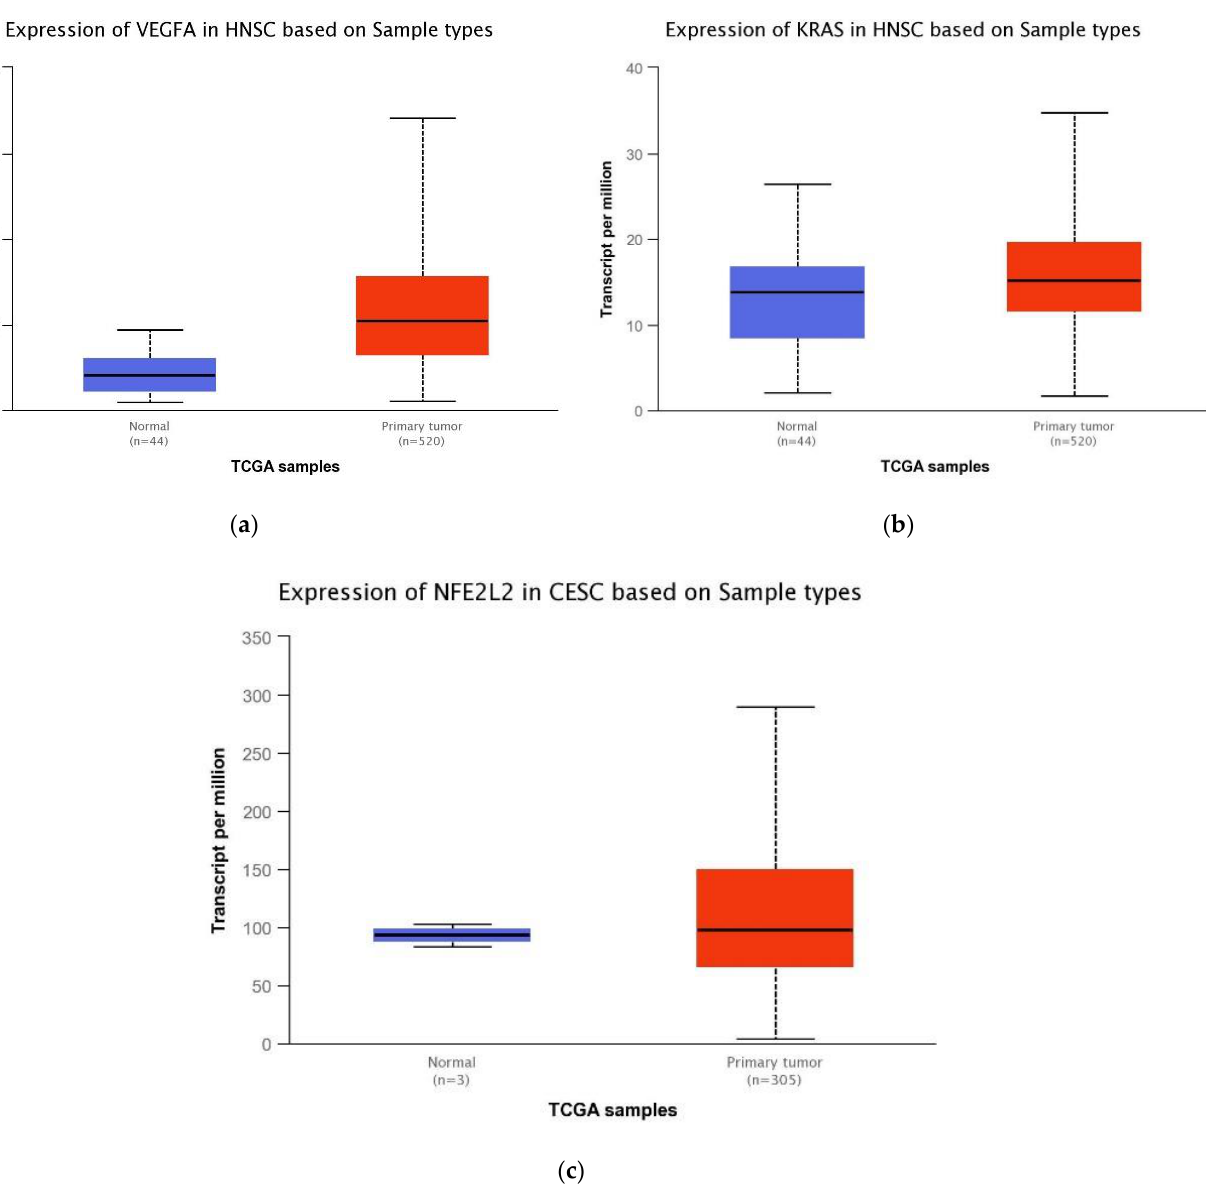
Figure 1. TCGA expression data of ( a ) VEGFA ( p = <0.001), ( b ) KRAS ( p = 0.80) and ( c ) NFE2L2 ( p = 0.70) in HNC, comparing normal tissue and primary tumor.